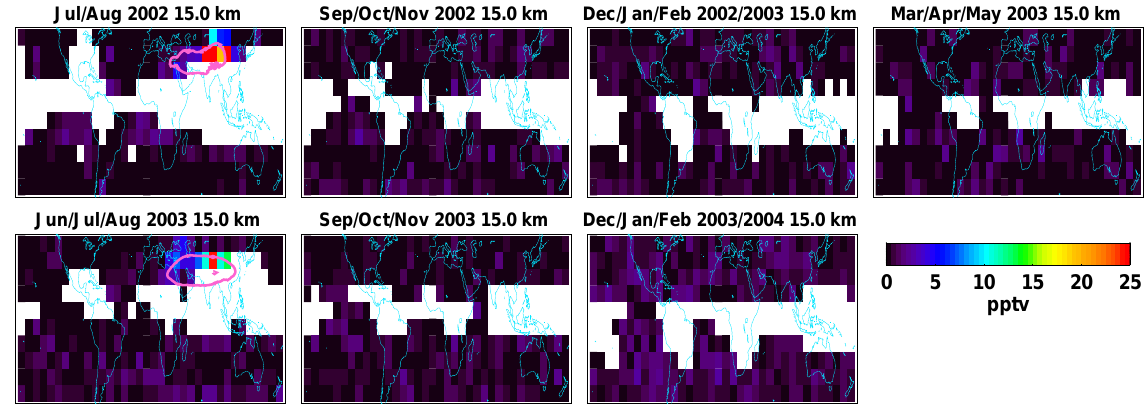
Figure 4. Distributions of NH 3 volume mixing ratios at 15km altitude between 50 ◦ N and 50 ◦ S retrieved from MIPAS seasonal mean spectra during the first measurement period. Pixels where not enough spectra for averaging were available are left white. To guide the eye, the pink lines denote the approximate position of the Asian monsoon anticyclone. It is the 2 × 10 − 6 Km 2 kg − 1 s − 1 contour of the mean potential vorticity for July and August in 2002 and June, July, and August in 2003 at the potential temperature level of 370K from the ECMWF ERA interim reanalysis (Dee et al., 2011) (e.g., Ploeger et al., 2015, and references